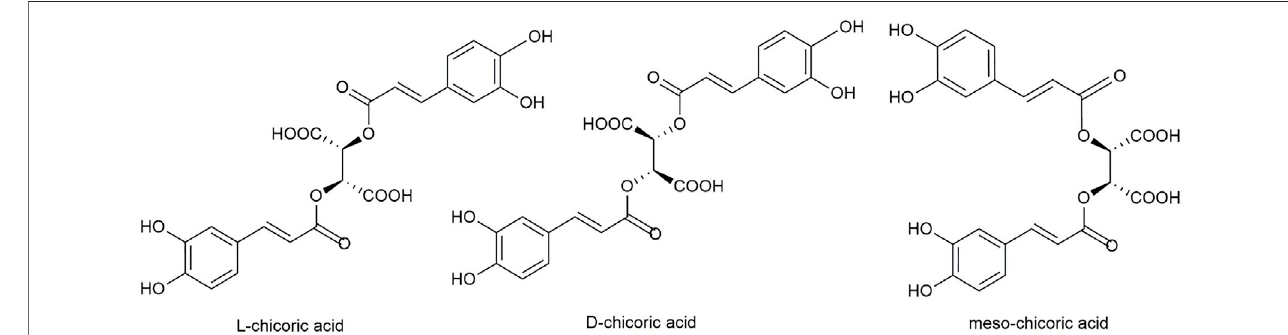
FIGURE 1 | Three optical structures of chicoric acid.